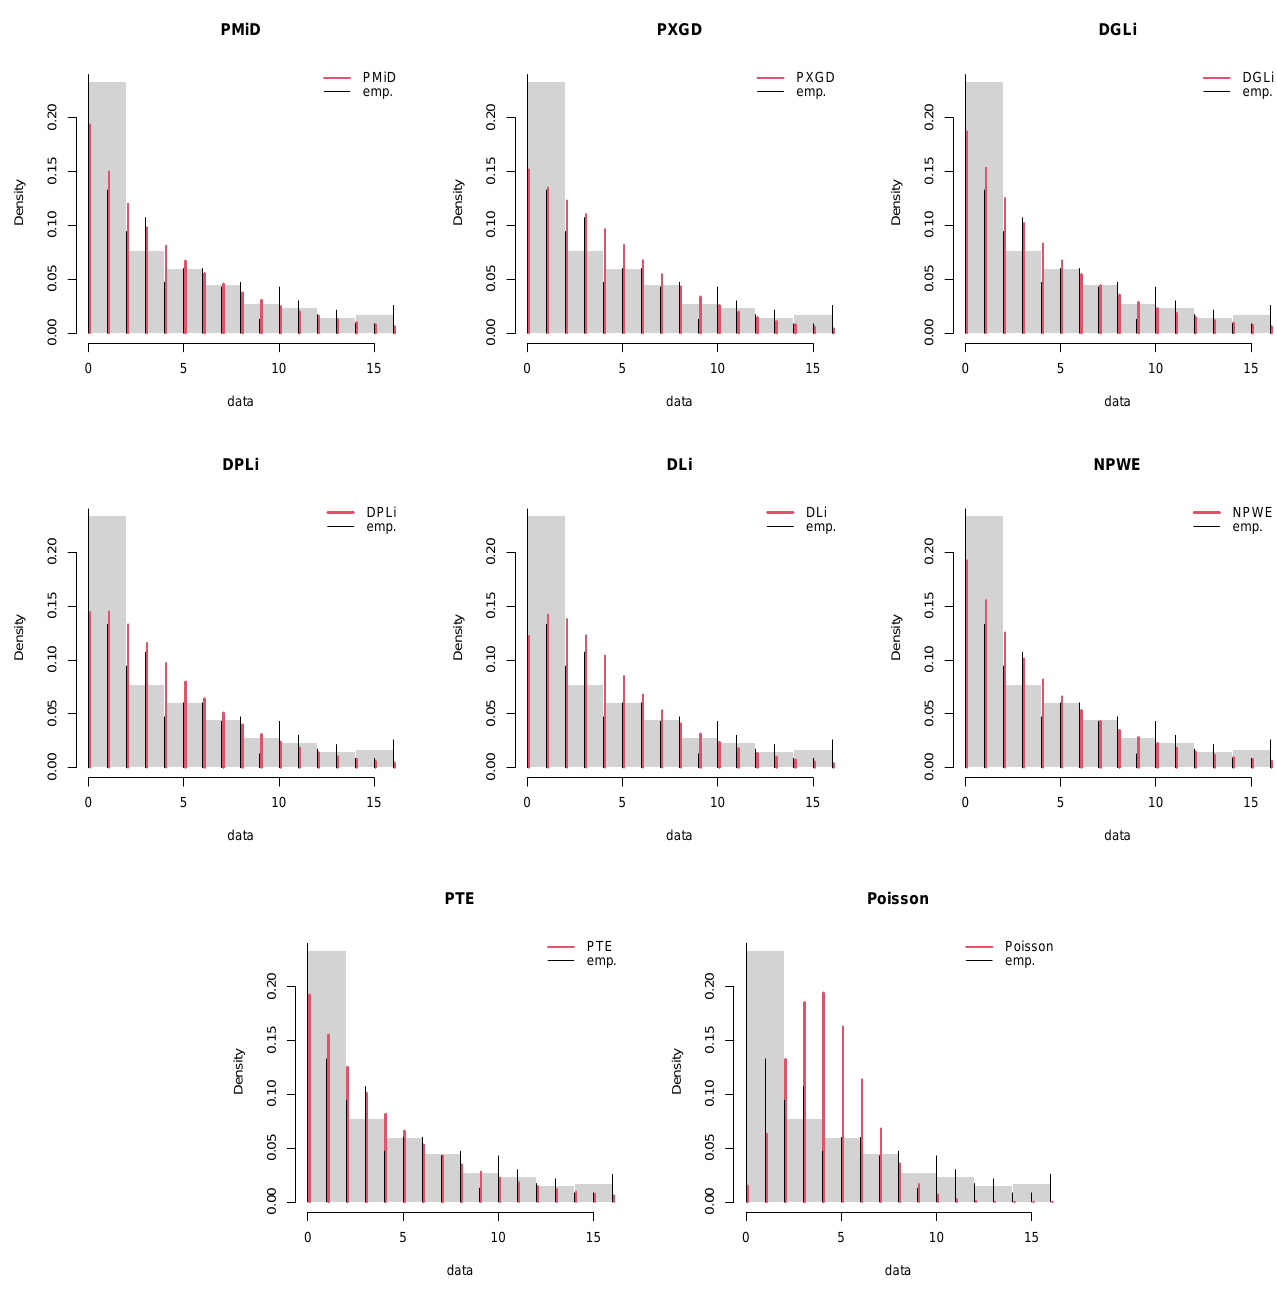
Figure 5. Empirical pmfs of the fitted distributions for the Armenia